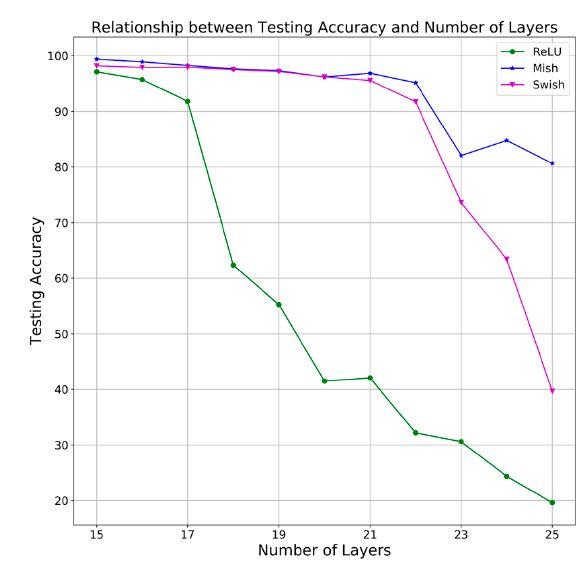
Figure 7. Graph to show the attributes of Mish activation.